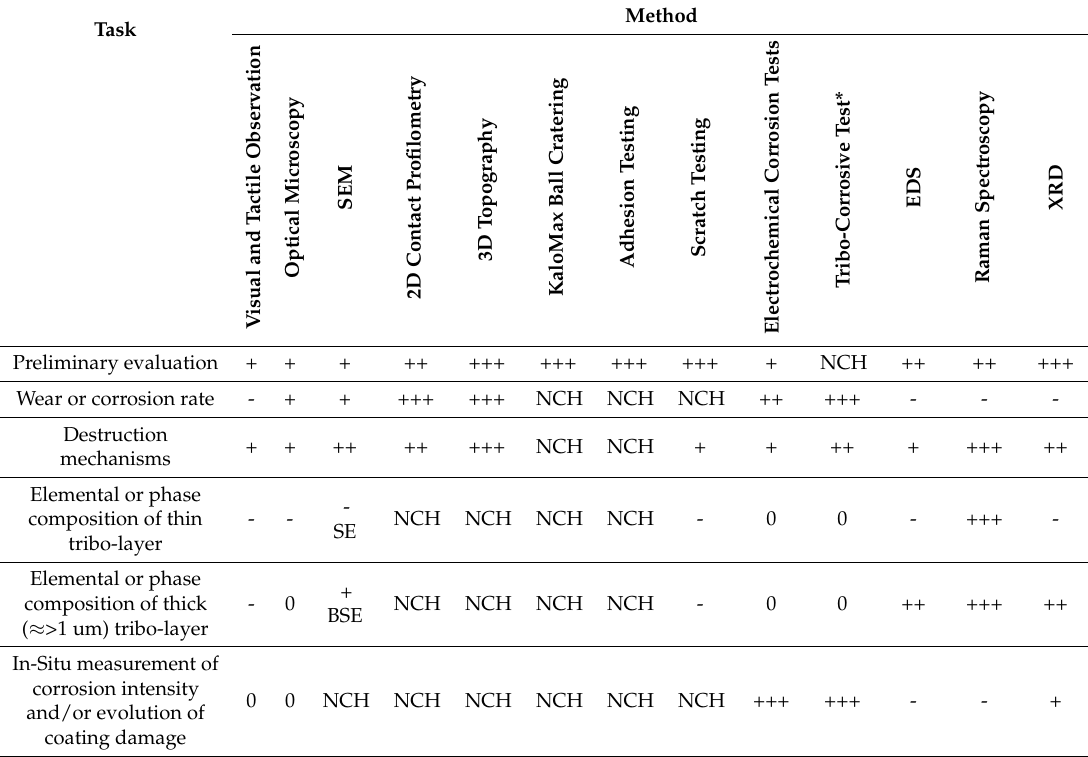
Table 2. Applicability of different methods for laboratory evaluation of various aspects of reliability of coatings intended for corrosive